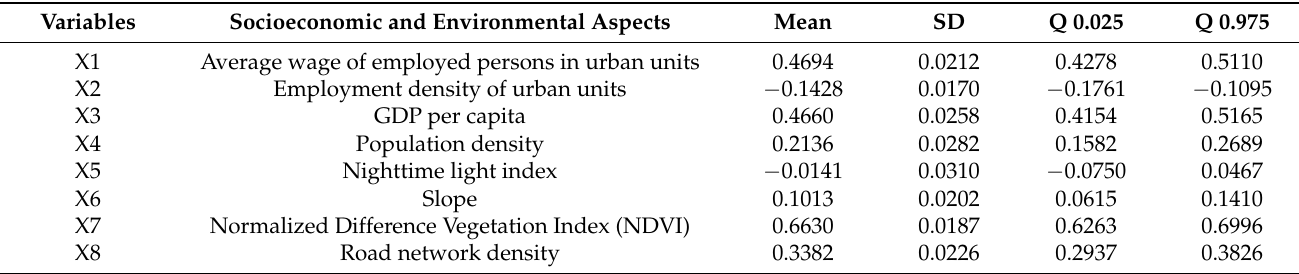
Table 3. Linear numerical impacts of main drivers on China’s city-level tourism industry. Variables Socioeconomic and Environmental